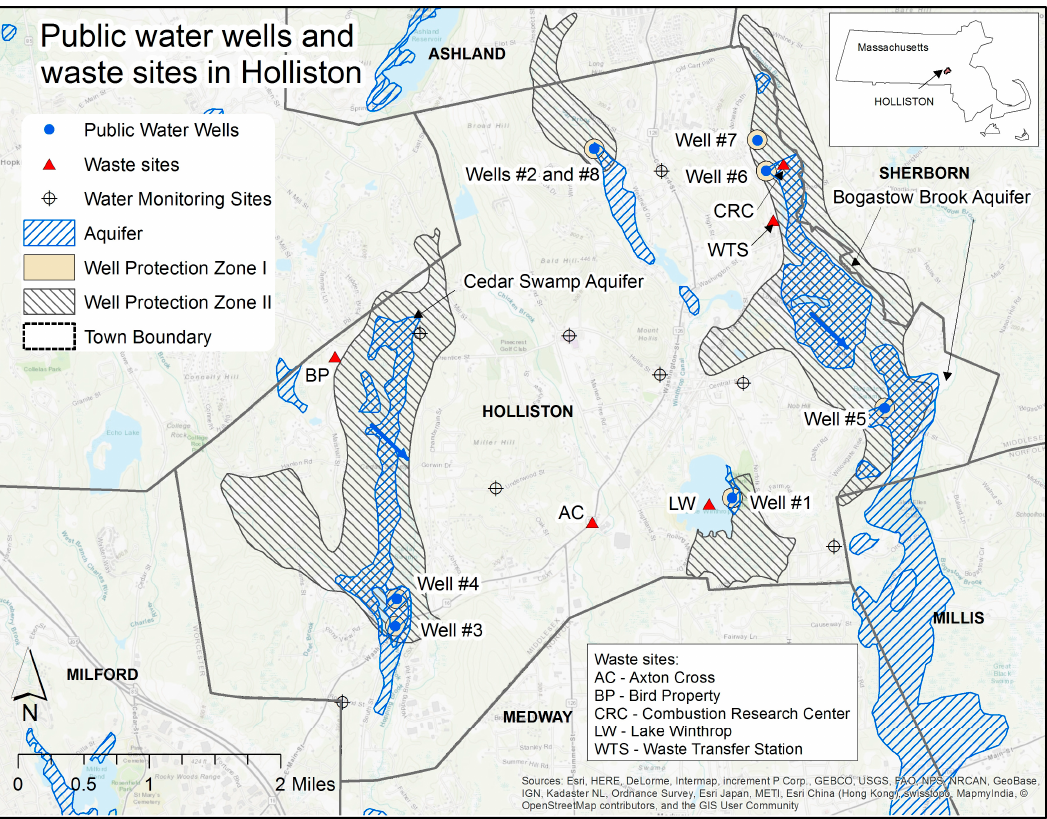
Figure 1. Public water wells and waste sites in Holliston, MA. Blue arrows indicate predominant ground water direction. Data sources: Bureau of Geographic Information (MassGIS), Commonwealth of Massachusetts, Executive Office of Technology and Security Services, Holliston Water Department.